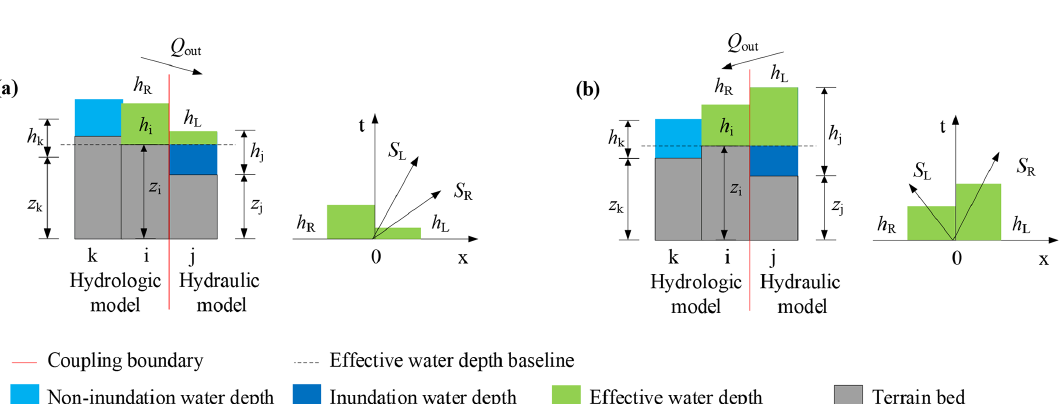
Figure 4. Direction of characteristic wave.